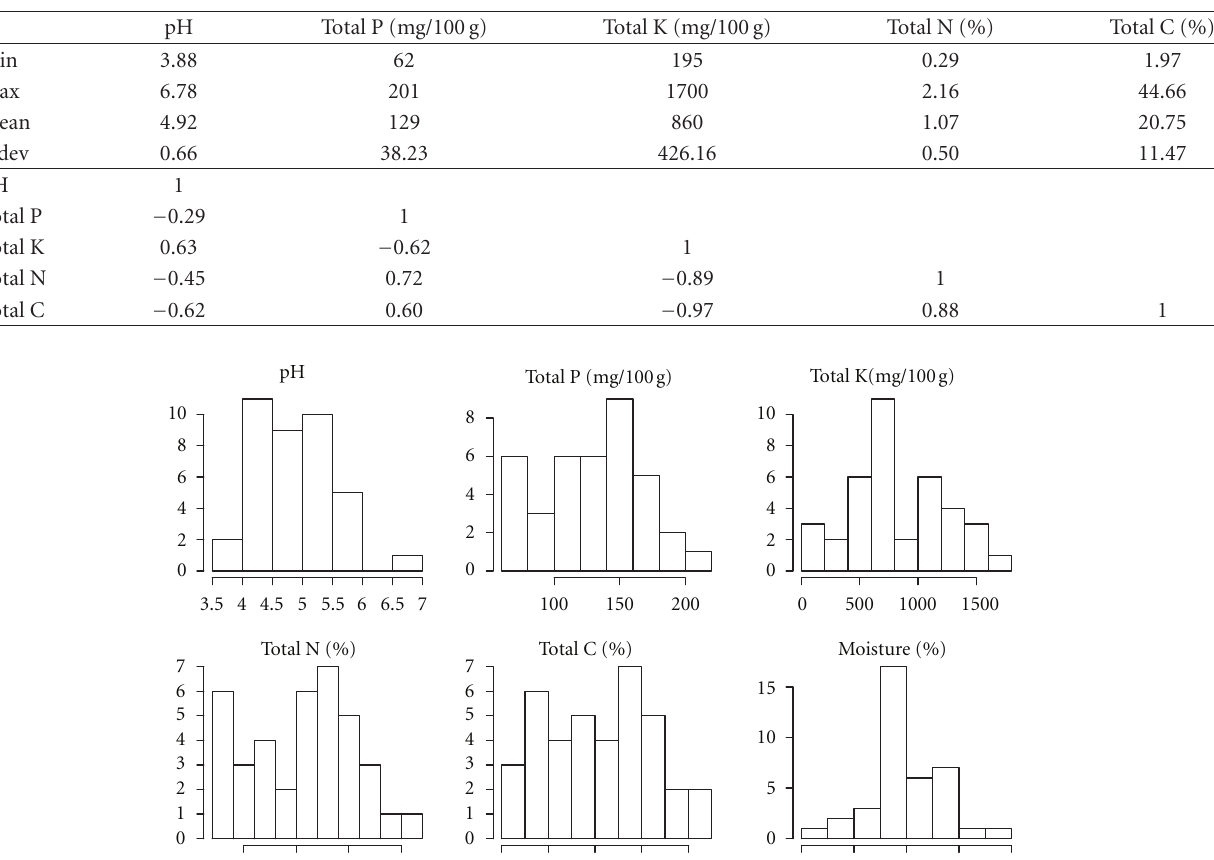
Table 1: Summary of chemical analysis and correlations ( R ) between soil properties.